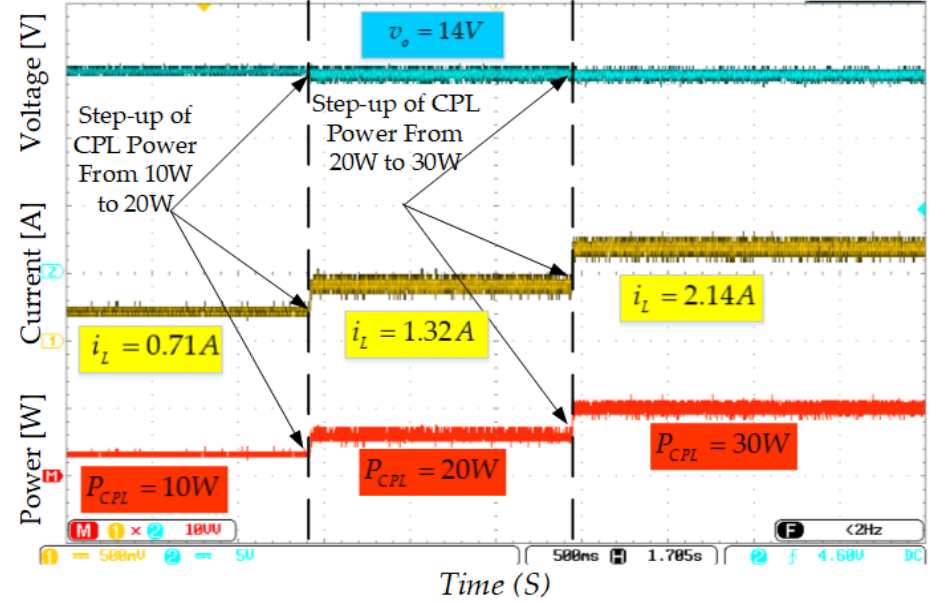
Figure 18. Experimental results of various step changes in the power absorbed by a CPL.